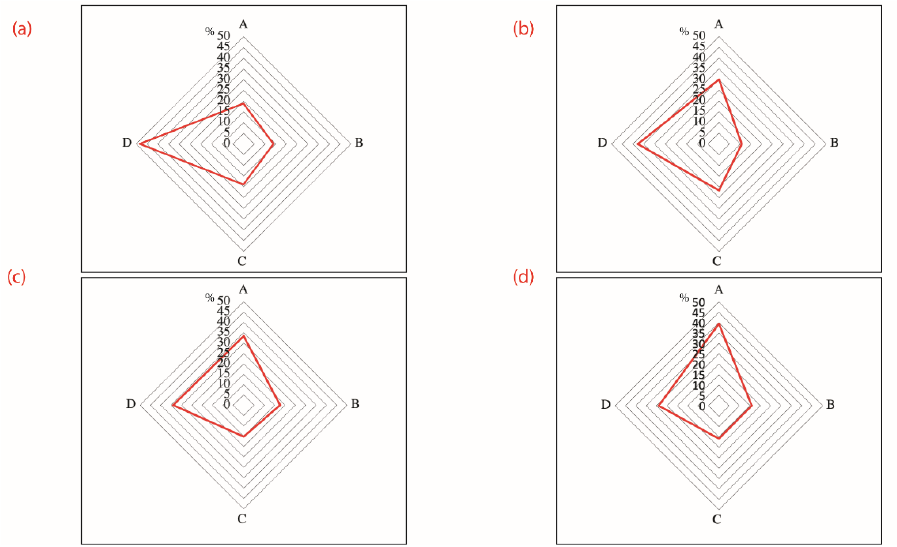
Figure 10. Range analysis of influential factors on the content of chloride ion in various depths of concrete samples eroded for 360 d under the wet–dry cyclic immersion condition: ( a ) 0–2 mm; ( b ) 2–5 mm; ( c ) 5 ‐ –10 mm; ( d ) 10–15 mm.